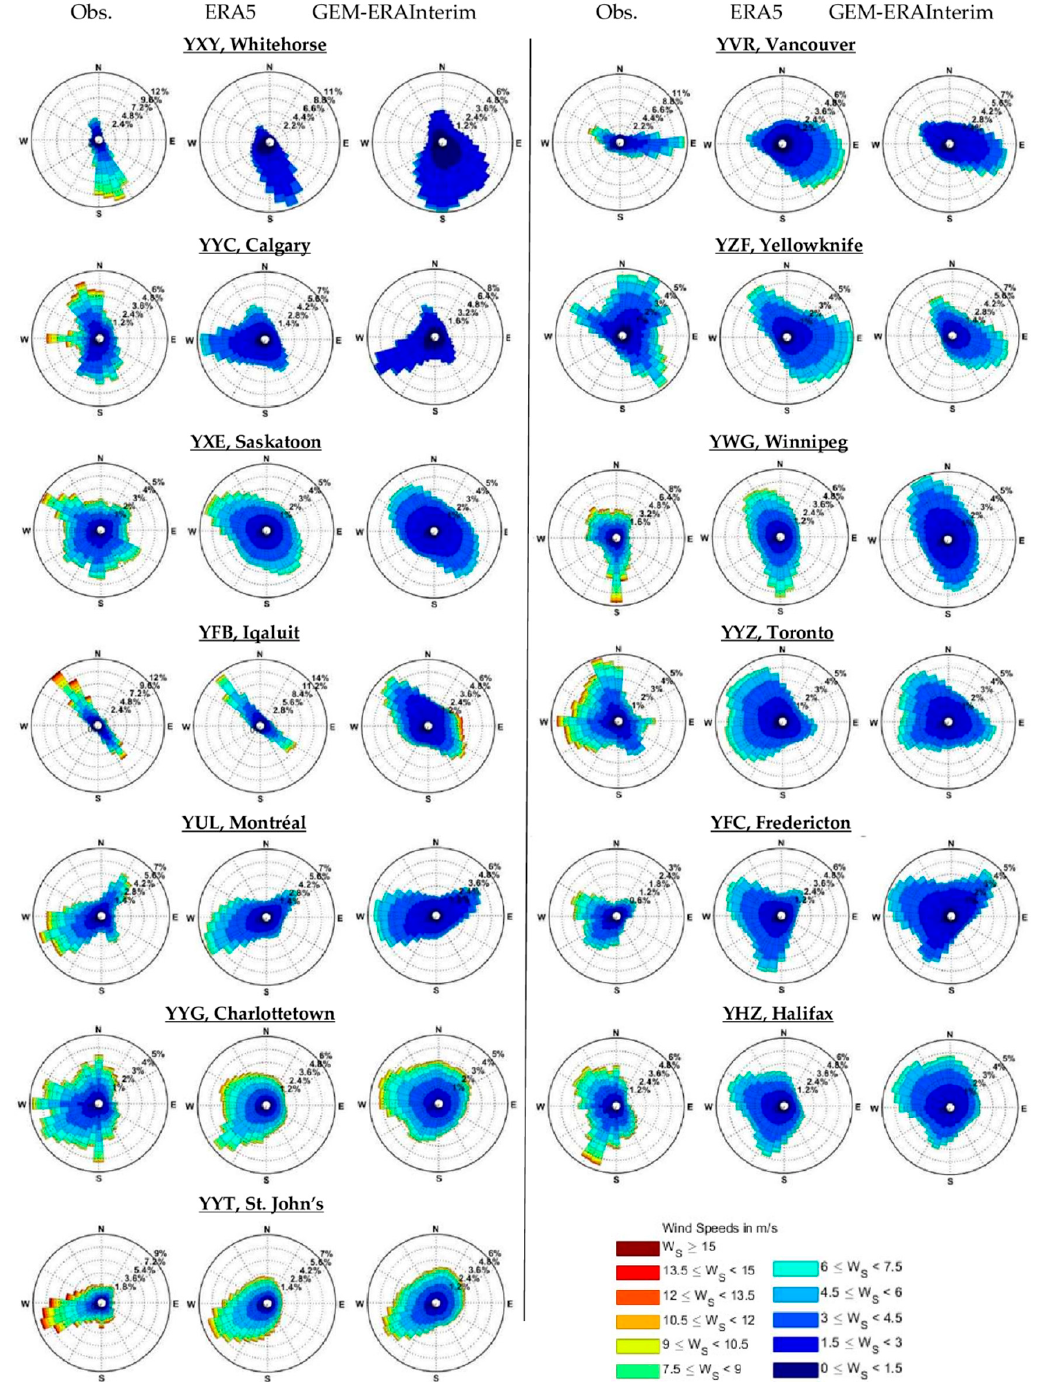
Figure 4. Distributions of wind direction and magnitude (m / s) from observations, ERA5 reanalysis and GEM-ERAInterim for the 1981–2010 period. Hourly wind magnitudes are considered for observations and ERA5, while three-hourly values are used for GEM-ERAInterim.